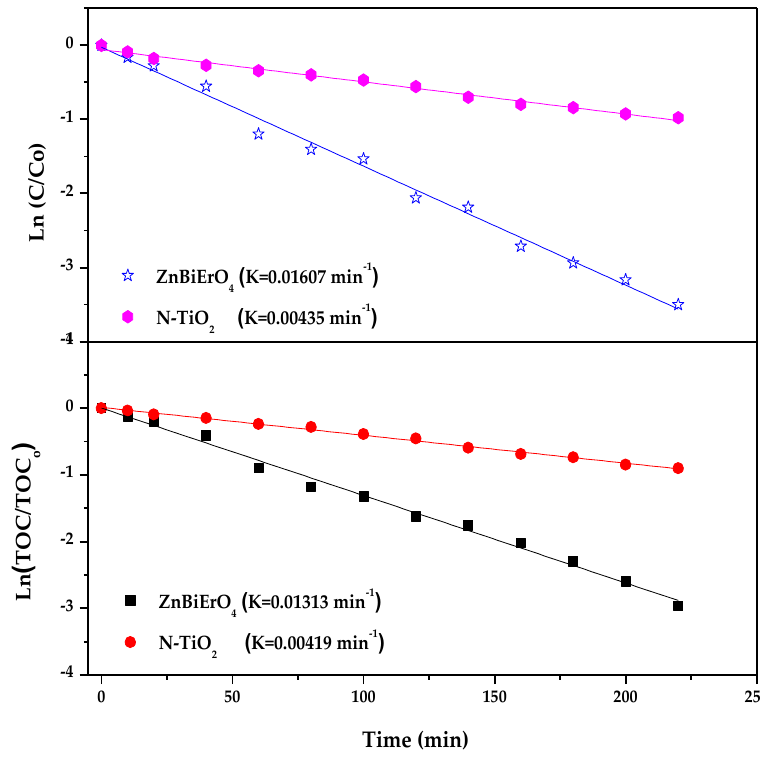
Figure 14. First-order kinetic plots for the photocatalytic degradation of methyl blue with ZnBiErO 4 or N-TiO 2 as catalyst under visible light irradiation.